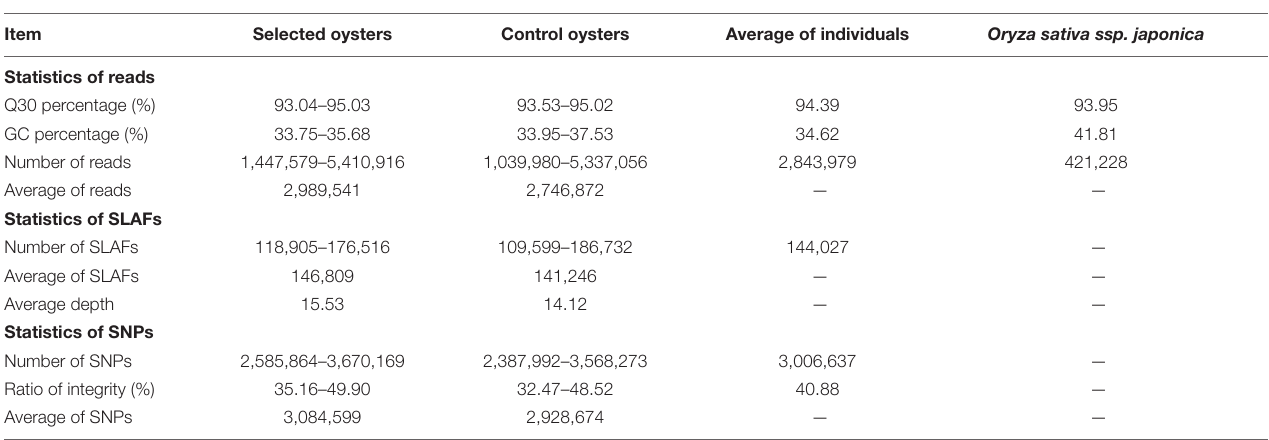
FIGURE 4 | The physiological parameter of selected and control oysters during heat shock at 37 ◦ C for 24 h ( n = 15). (A) MDA, malondialdehyde; (B) protein; (C) PK, pyruvate kinase; (D) SOD, superoxide dismutase. Bars denote standard deviation. ∗ Indicates p < 0.05, ∗∗ indicates p < 0.01. TABLE 1 | Characteristics of SLAF-seq between selected and control